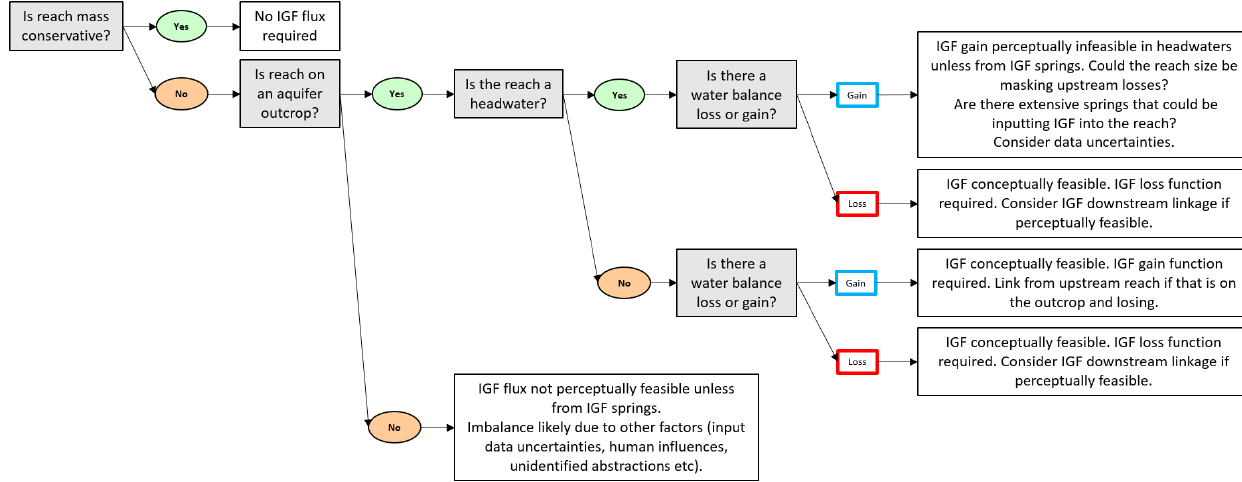
Figure 2. Perceptual roadmap for high-level initial identification of river reaches with possible intercatchment groundwater flow, from a physical process-based assessment. Note that more than one process may be at work in a single reach, e.g. both incoming IGF from upstream river reaches and outgoing IGF to downstream river reaches.